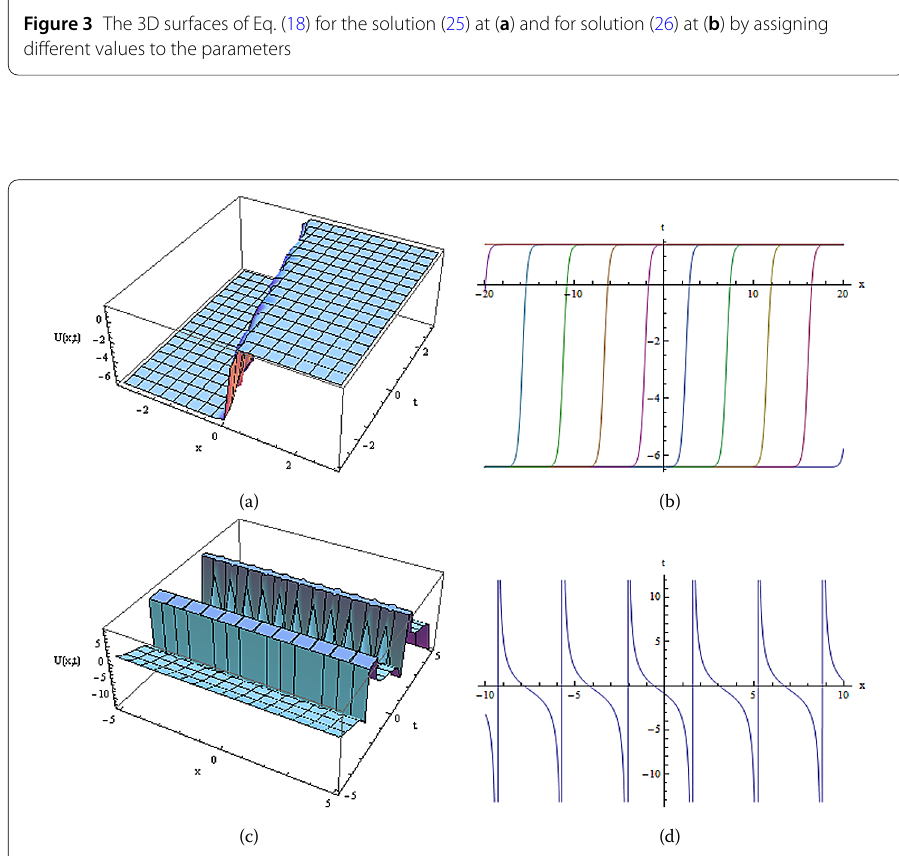
Figure 4 The 3D surfaces of Eq. (27) for solution (32) at ( a ) and for solution (33) at ( b ) are plotted under the necessary constrain conditions on the parameter